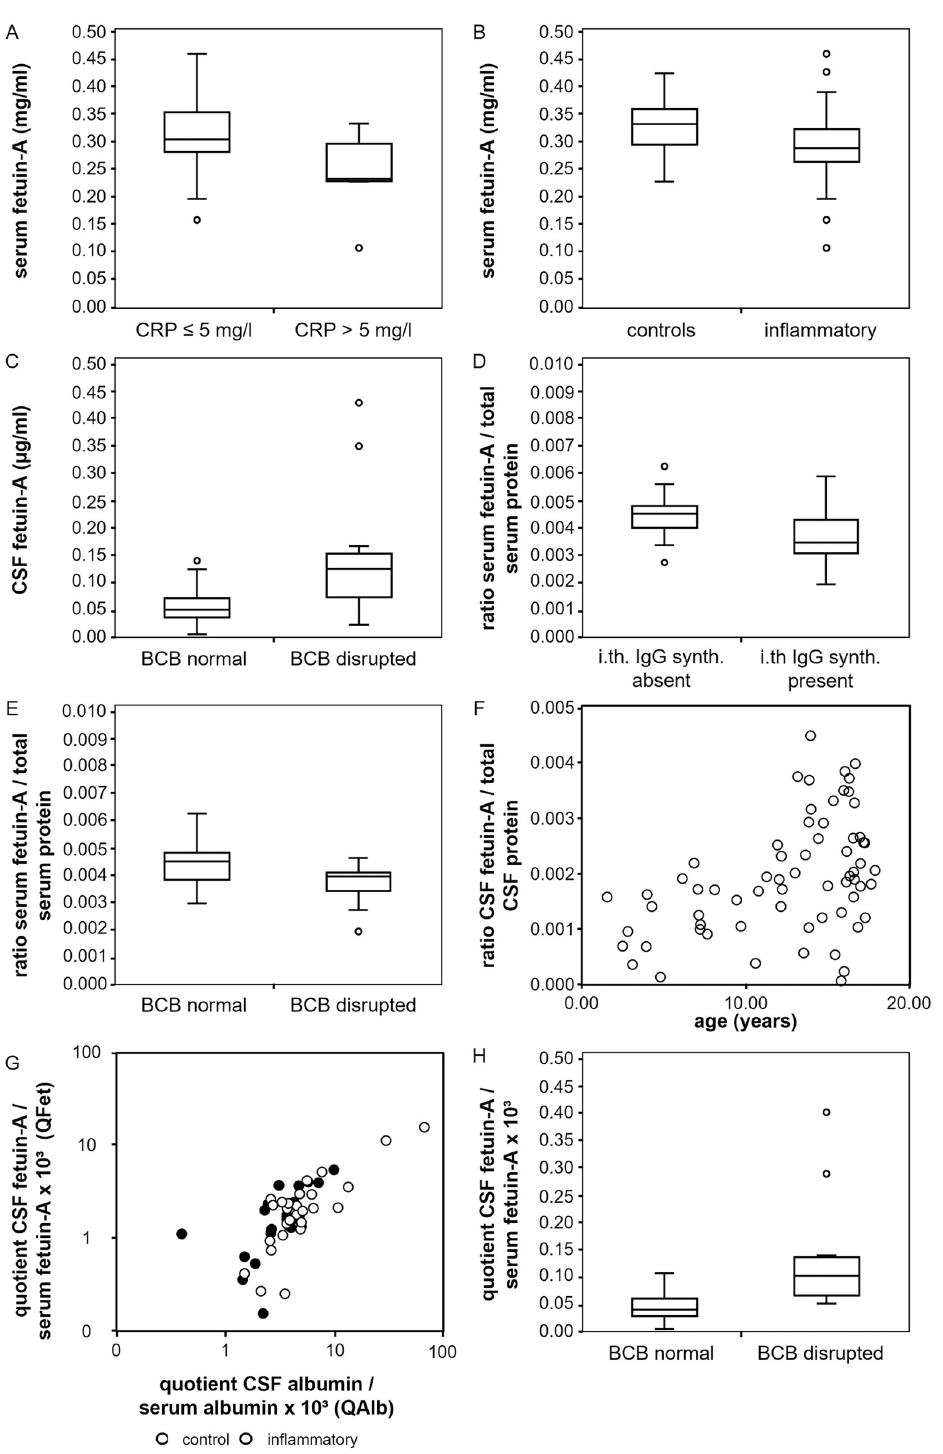
Fig 1. Concentrations of fetuin-A in serum and CSF. Fig 1 shows the results of the concentration measurements of fetuin-A in CSF and serum. The correlation of fetuin-A in serum (y-axis, mg/ml) with an elevated C-reactive protein concentration (x-axis, (A)) and the presence of neuroinflammatory disease (x-axis, (B)) is shown. The relation between fetuin-A in CSF (y-axis, μ g/ml) and a disruption of the blood-CSF barrier (x-axis) is displayed in (C). (D) and (E) show the connection of the serum fetuin-A/total serum protein ratio (y-axis) with an intrathecal IgG synthesis (x-axis, (D))